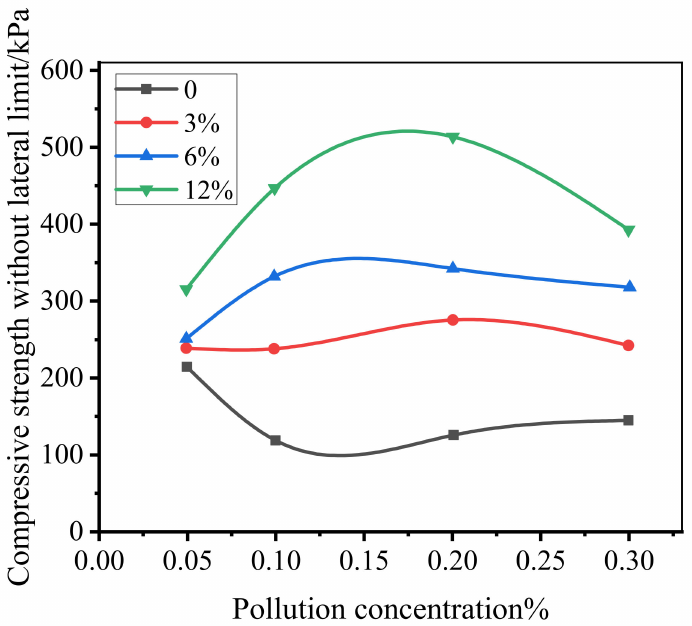
Figure 3. Changes in contamination concentration and unconfined compressive strength of contami- nated soil before and after